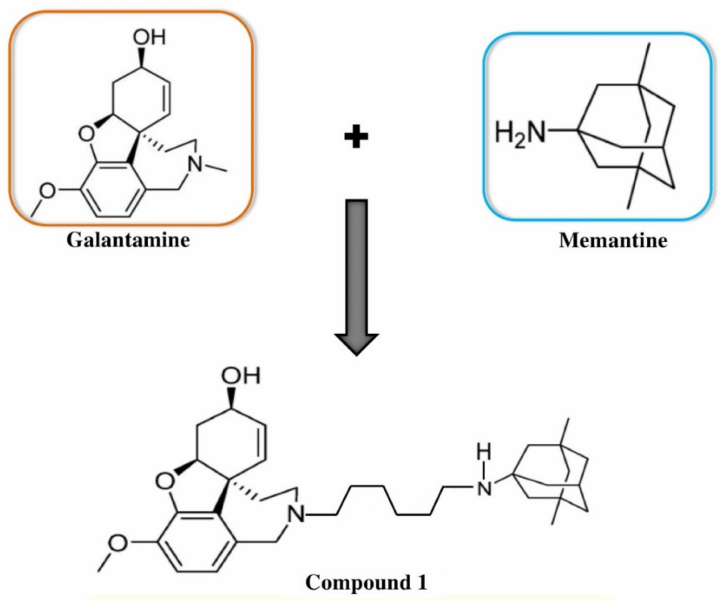
Figure 1. Chemical structure of one heterodimer of galantamine and